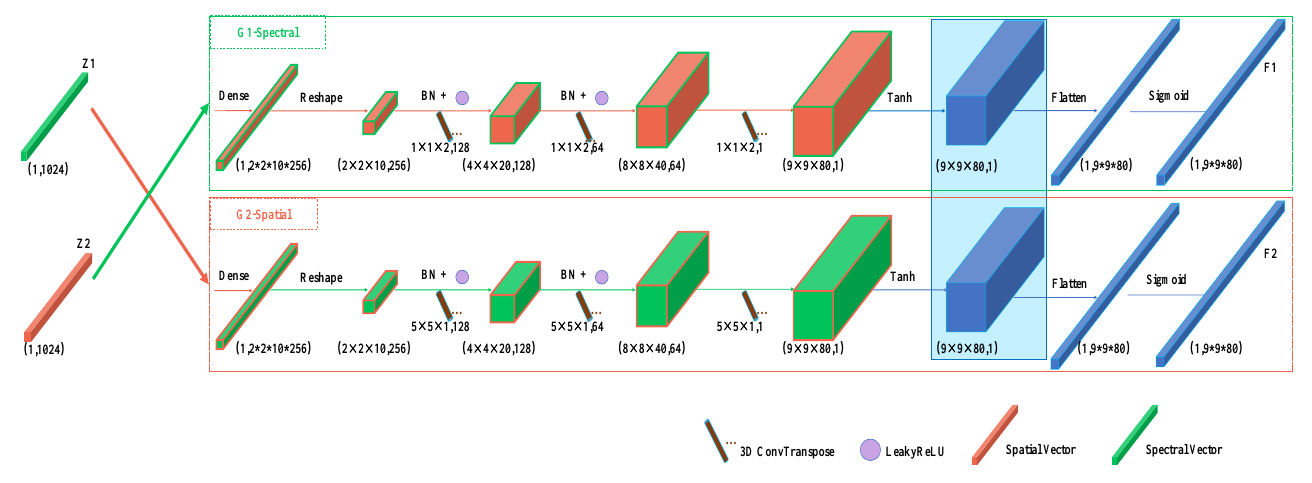
Figure 5. The Crossed Interactive Generator in